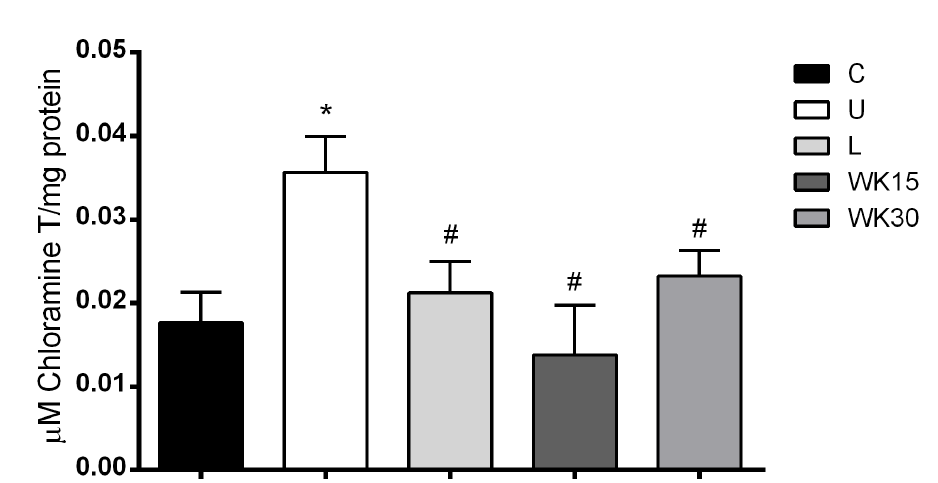
FIGURE 2 - Evaluation of advanced oxidized protein products (AOPPs) in stomach tissue. Both water kefir and lansoprazole promoted a decrease in AOPP values after 14 days of treatment. *p<0.05 compared to C; #p<0.05 compared to U. Data are presented as mean ± standard error of the mean